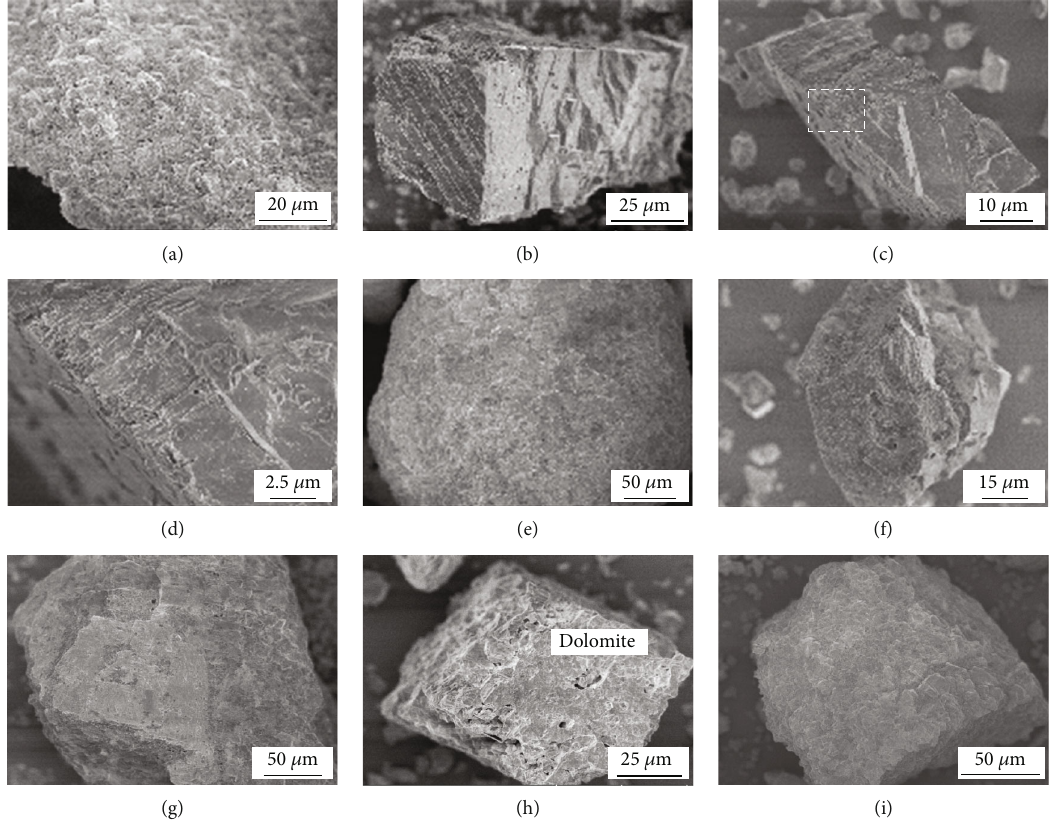
Figure 4: SEM images of initial and altered rock grains in the limestone series. (a) Calcite grain with few pores in initial limestone; (b) crystalline calcite without pores in initial limestone; (c) crystalline calcite with a corroded edge at 50 ° C; (d) enlarged image of corroded edge (dotted box in 4c); (e – g) calcite with blurred grain boundaries at 100 ° C (e) and 150 ° C (f – g); (f) corroded dolomite crystal at 150 ° C; (i) calcite with blurred grain boundary at 200 °